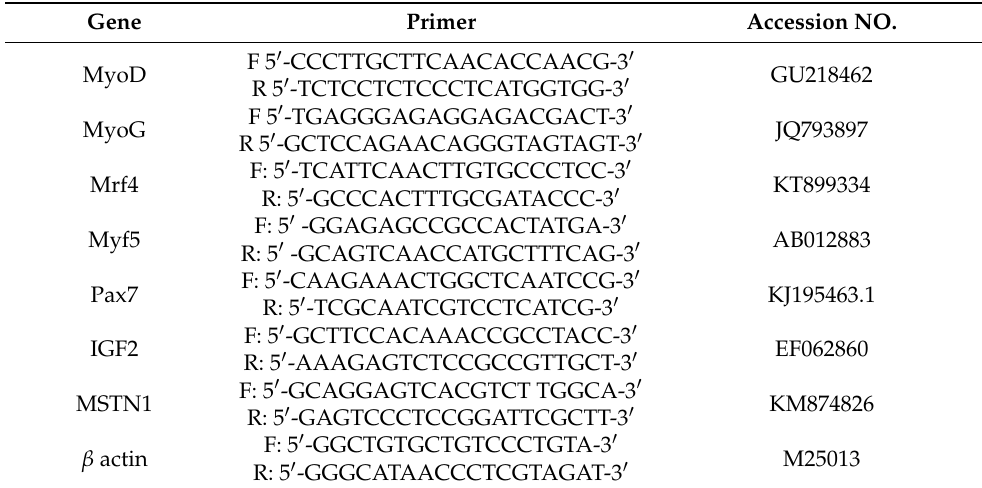
Table 2. Real-time PCR primer sequences.